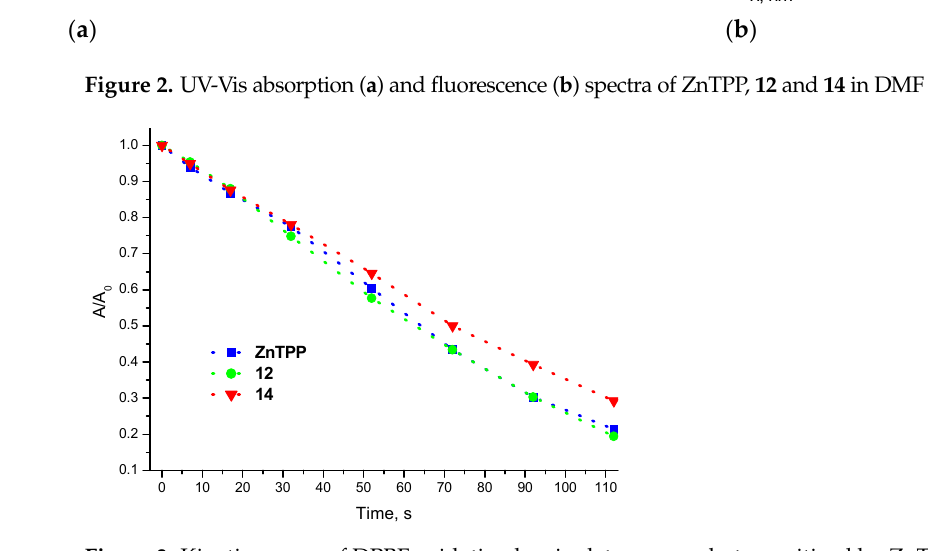
Figure 3. Kinetic curves of DPBF oxidation by singlet oxygen photosensitized by ZnTPP, 12 and 14 .